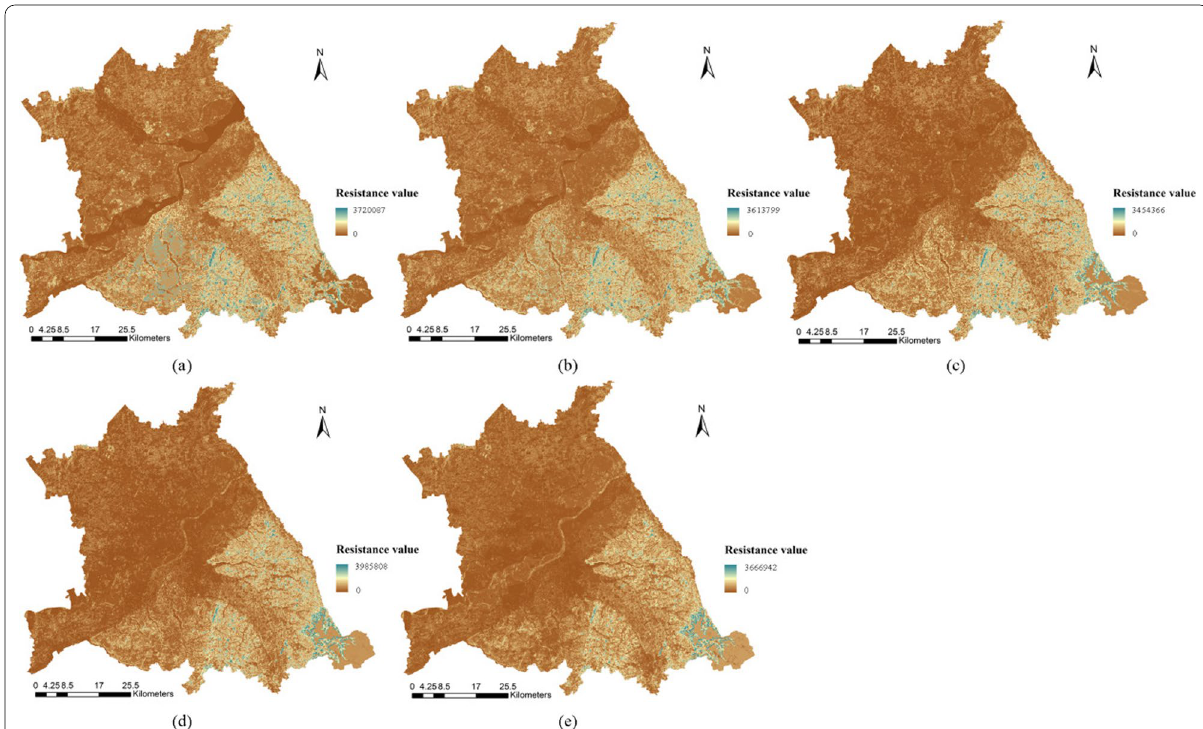
Fig. 4 Resistance surface of the study area in multiple scenarios. a Current scenario, b 5% economic growth scenario, c 10% economic growth scenario, d 15% economic growth scenario, e 20% economic growth